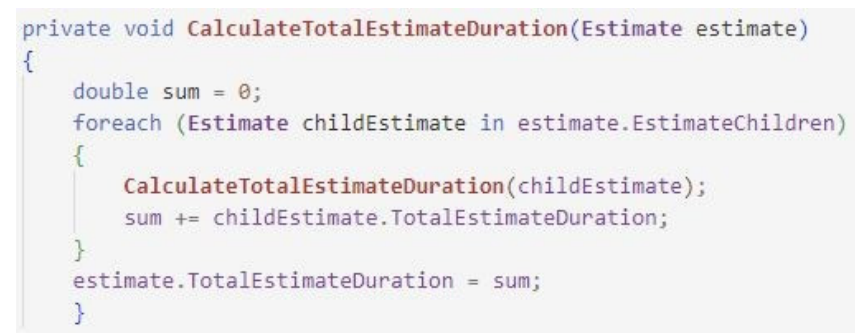
Figure 7. Pseudocode for calculating time estimation.